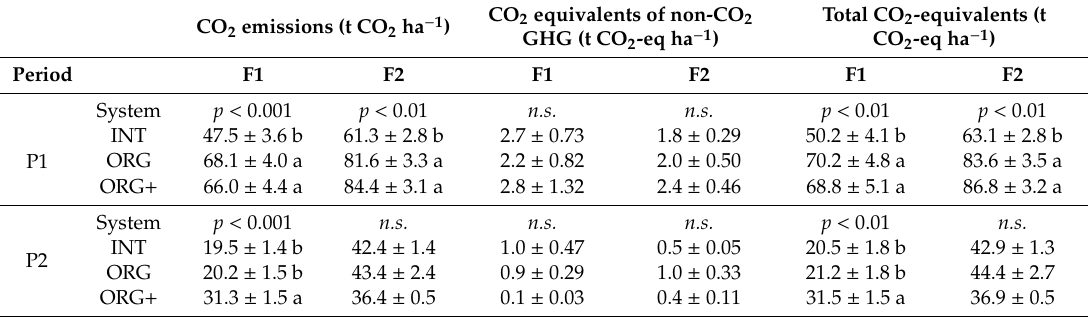
Table 5. Estimated cumulative CO 2 emissions (t CO 2 ha − 1 ): CO 2 equivalents of non-CO 2 GHG